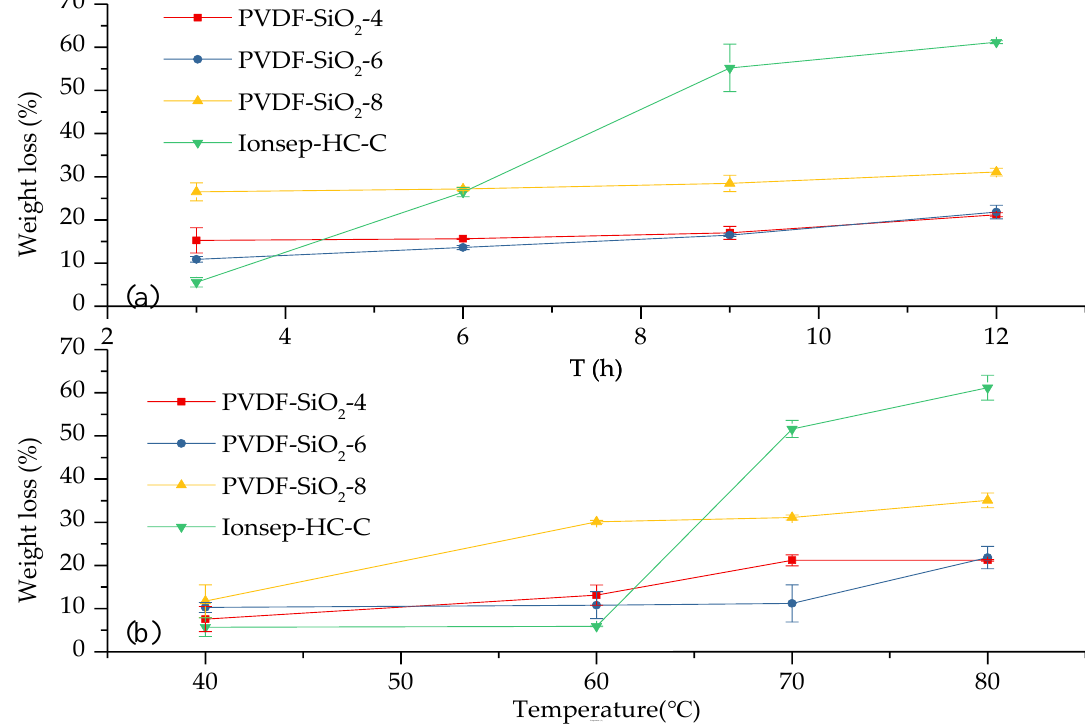
Figure 11. Weight loss of the organic – inorganic hybrid PVDF-SiO 2 and Ionsep-HC-C membranes as a function of the temperature of the Fenton’s reagent solution during ( a ) 3, 6, 9, and 12 h tests at 80 °C and ( b ) during 12 h tests at 40, 60, 70, and 80 °C.